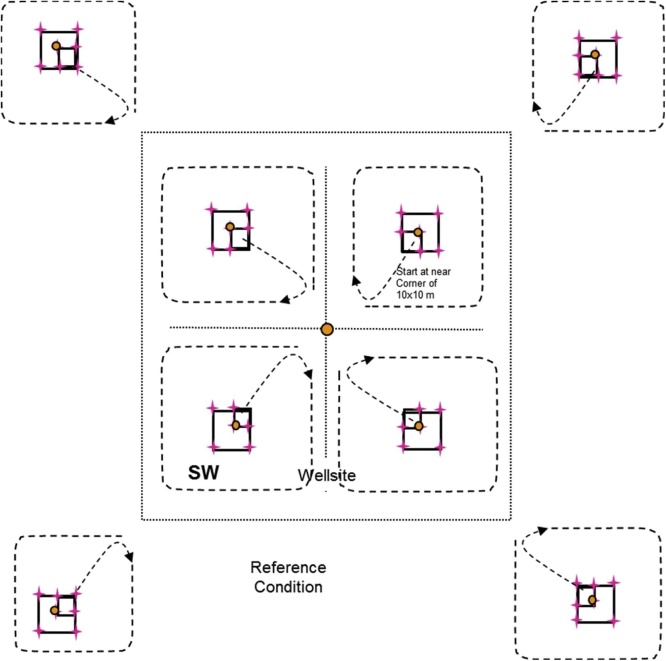
Layout of survey to identify vascular plant richness within the wellsite and reference areas.